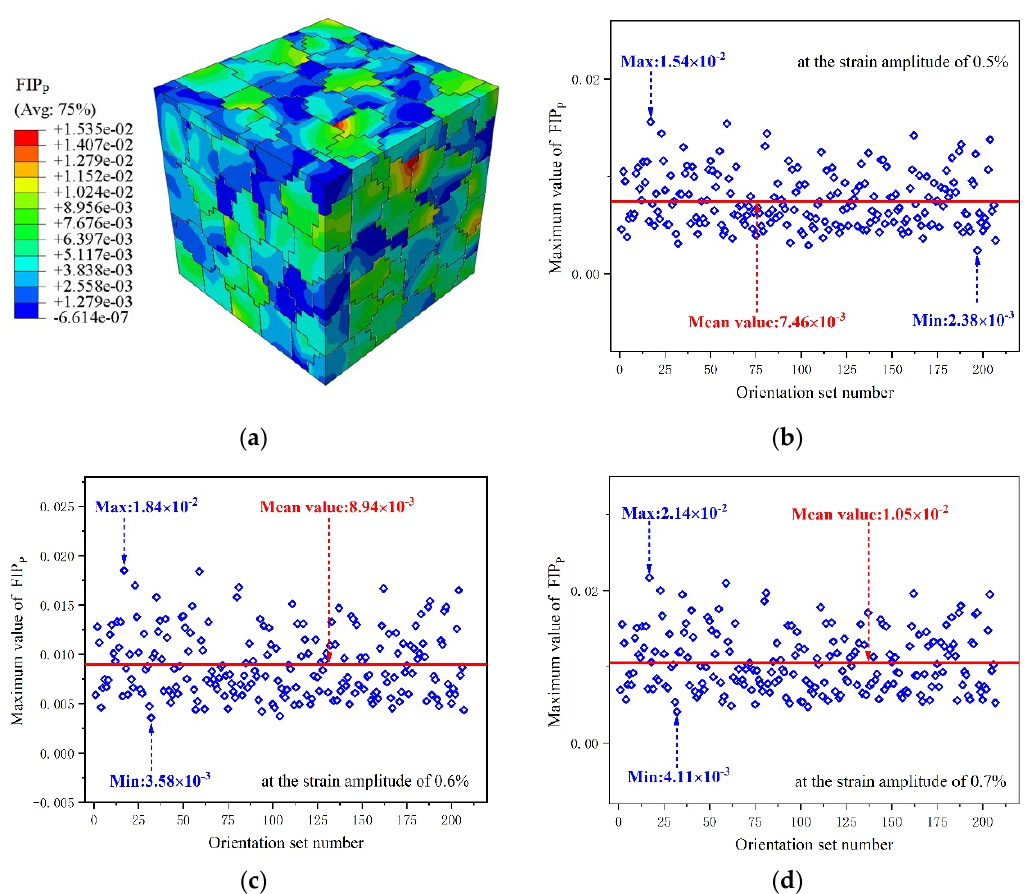
Figure 15. ( a ) Distributions of FIP p by contours with respect to the strain amplitude of 0.5%. Effect of the grain orientation on the maximum FIP p at a strain amplitude of ( b ) 0.5%, ( c ) 0.6%, and ( d ) 0.7%.